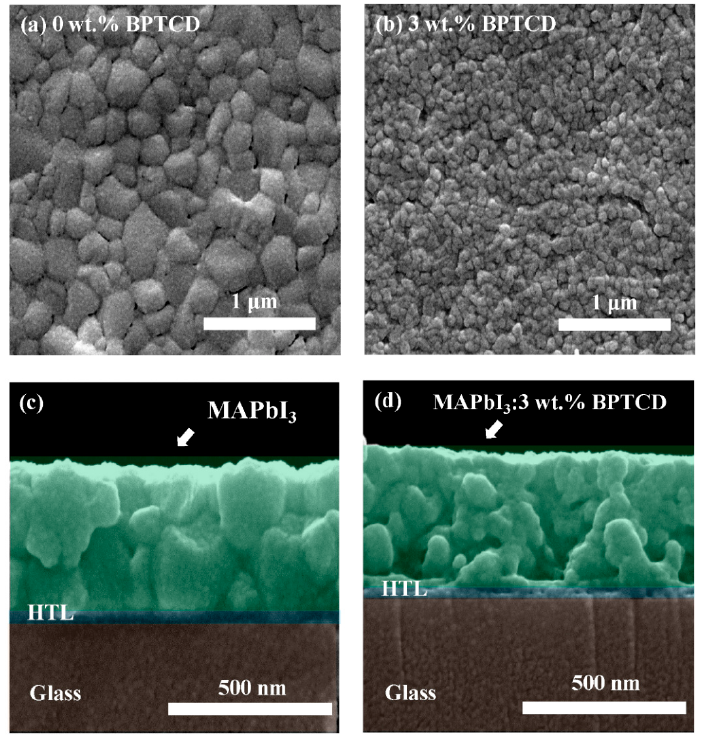
Figure 3. Top SEM images of perovskite films with ( a ) 0 and ( b ) 3 wt.% BPTCD additives. Cross SEM images of perovskite films with ( c ) 0 and ( d ) 3 wt.% BPTCD additives. Micromachines 2020 , 11 , x